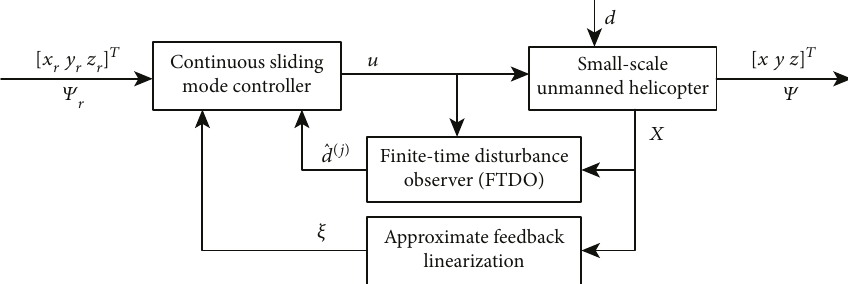
Figure 2: The fl ight controller structure of a small-scale unmanned